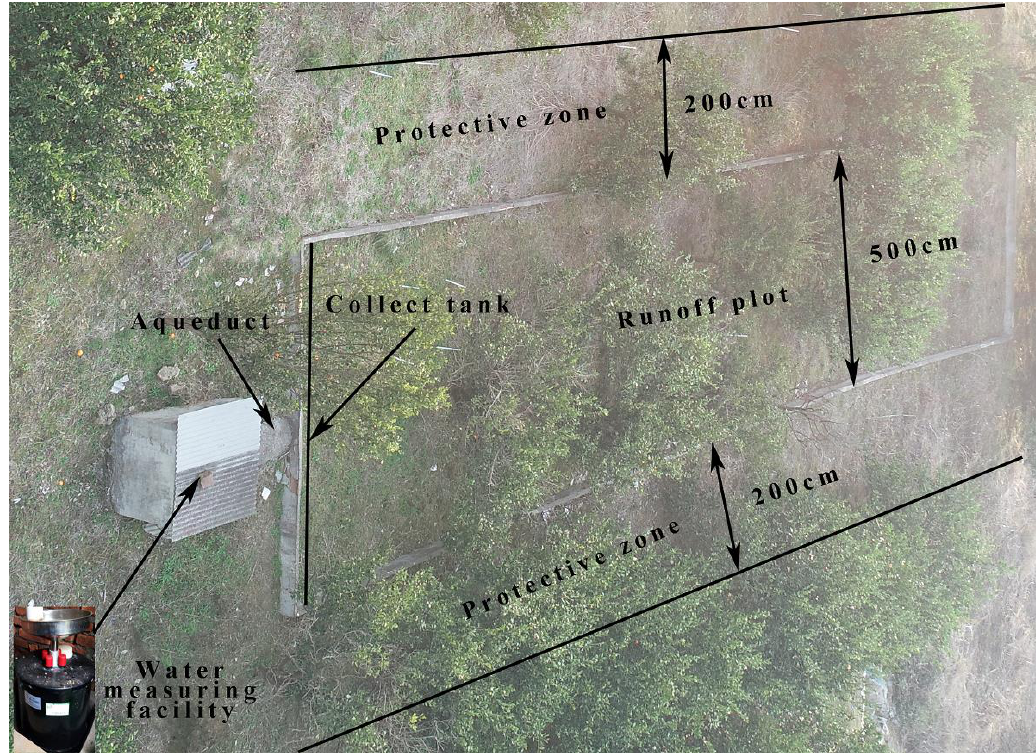
Figure 2. Scheme of the experimental setup.